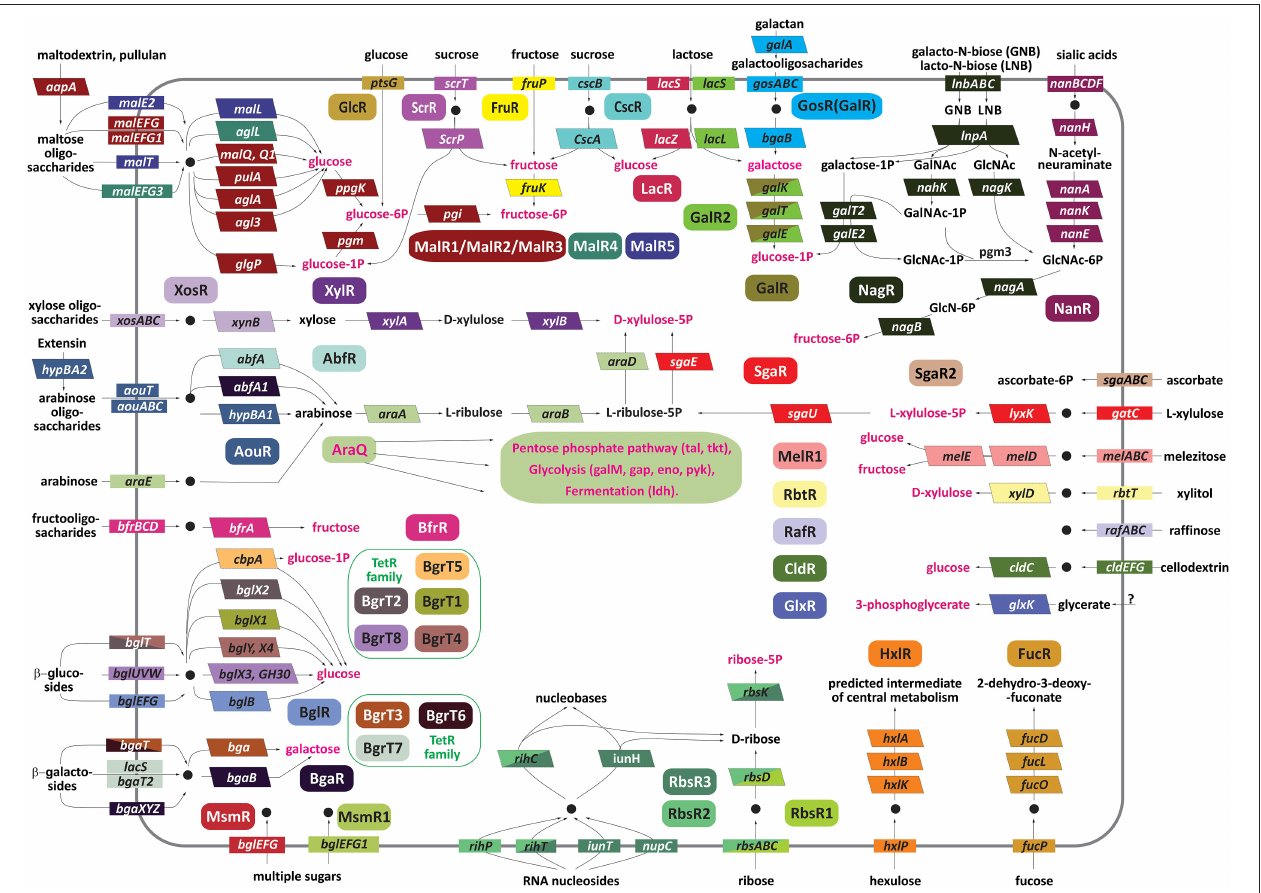
FIGURE 1 | Carbohydrate utilization pathways involved in the reconstructed transcriptional regulatory network in bifidobacterial genomes. The regulators are denoted by ovals; transporters are shown by rectangles, and enzymes are shown by bent rectangles. The genes regulated by the same TF are shown by matching background colors. The genes that are regulated by two different regulators are colored by both colors in diagonal segments. Common intermediates of the central carbohydrate metabolism are shown in red. Note that none of the individual Bifidobacterium species contain all of the shown pathways. The utilized compounds transported into the cell are depicted by black